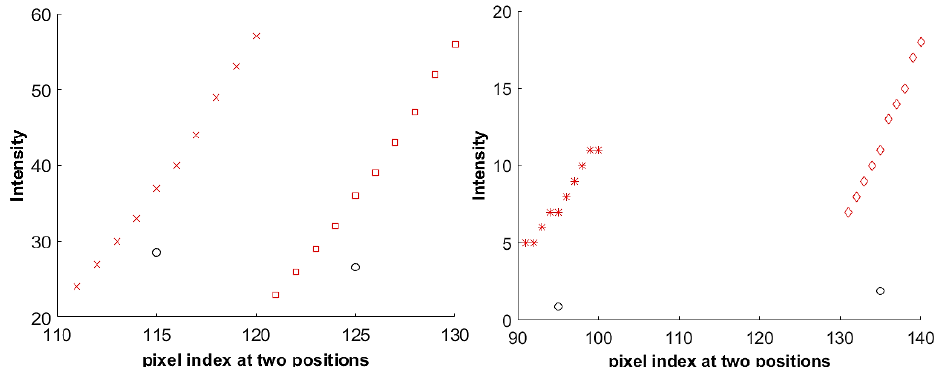
Figure 6. The examples of inliers ( left ) and outliers ( right ) of image irradiance points. The black circles represent the estimated sensor irradiance 𝐸 𝑖 for the respective pixel position index of 𝑖 . Each set of ten intensity values for each pixel position; obtained from fill factor variation, are shown with certain color and shape.